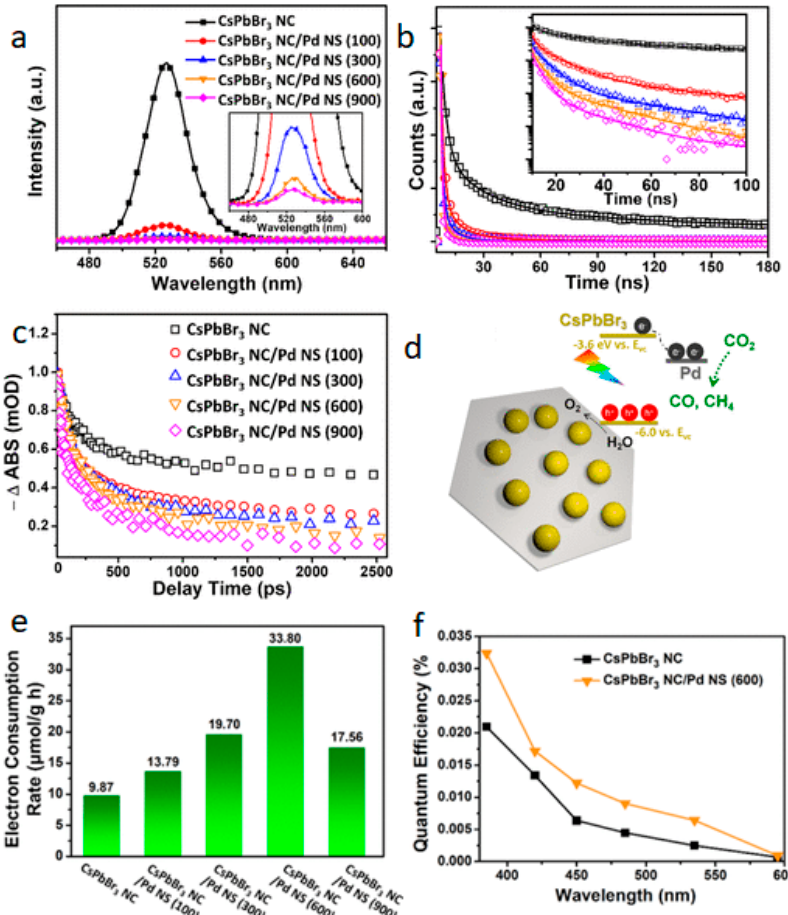
Figure 3. The comparative ( a ) PL spectra, ( b ) PL decay, ( c ) transient absorption kinetic plots (at an excitation wavelength of 400 nm) among CsPbBr 3 NC and composite samples, ( d ) schematic illustration and band alignment of CsPbBr 3 /Pd composite for CO 2 reduction, ( e ) photocatalytic CO 2 reduction performance, and ( f ) quantum efficiency of different samples. Reproduced from [76], with permission from Royal Society of Chemistry, 2019.